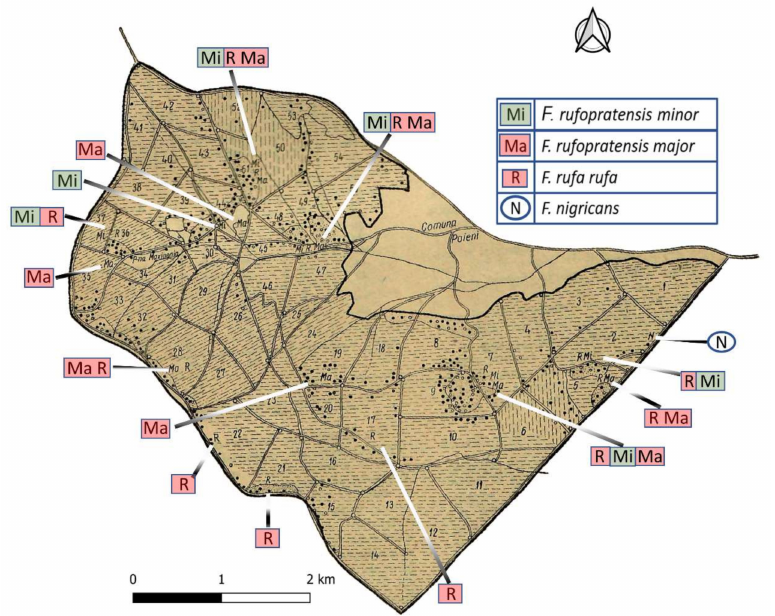
Figure 2. Map of 1960 Poieni inventory area with stand compartments and major roads, Red Wood Ants (RWA) positions shown as black dots (adapted from Pascovici [11], reproduced with kind permission of the journal “Revista P ă durilor”). (Currently valid Formica species names are: Mi = F. polyctena , Ma = F. rufa (presumably oligogynous), R = F. rufa (presumably monogynous), N = F. pratensis